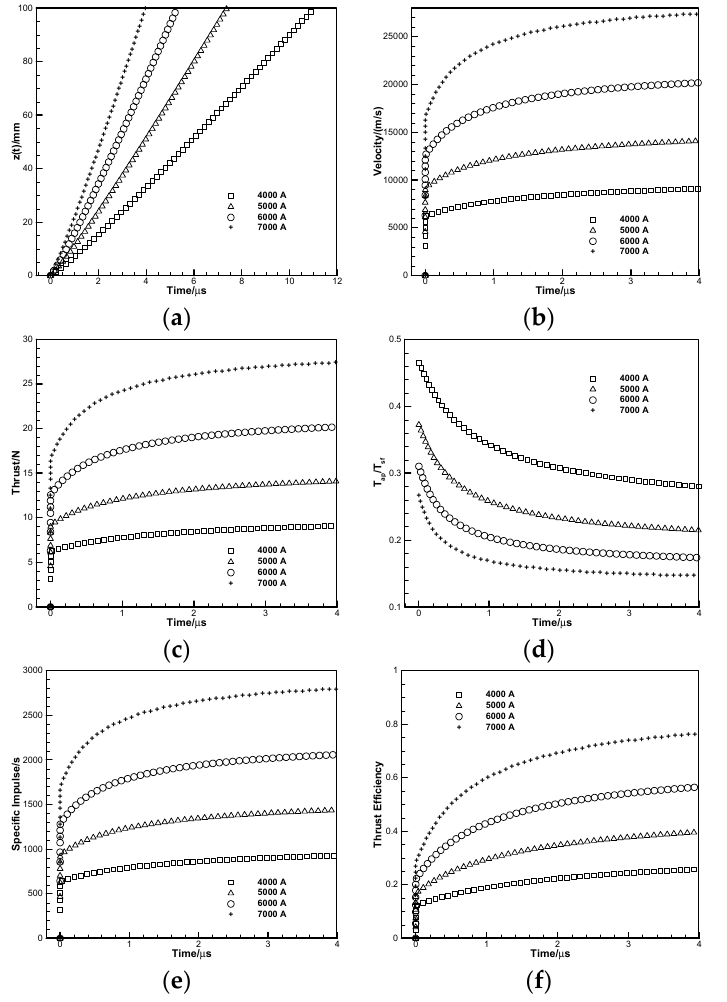
Figure 8. Effects of discharge current on thrust performances: ( a ) Axial movement of current sheet; ( b ) Velocity of current sheet; ( c ) Thrust; ( d ) Ratio of applied-field thrust to self-field thrust; ( e ) Specific impulse; ( f ) Thrust efficiency.